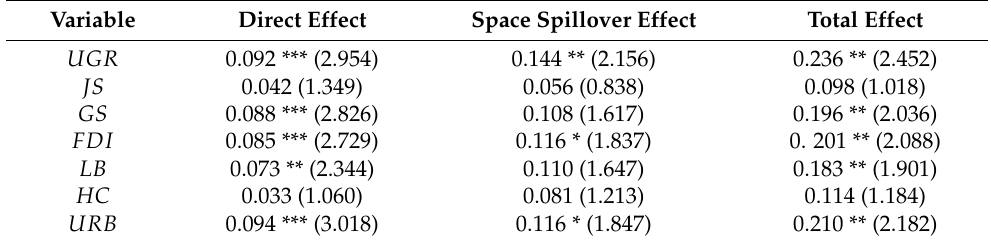
Table 7. Direct, indirect, and spatial effects representing the influence of explanatory variables.